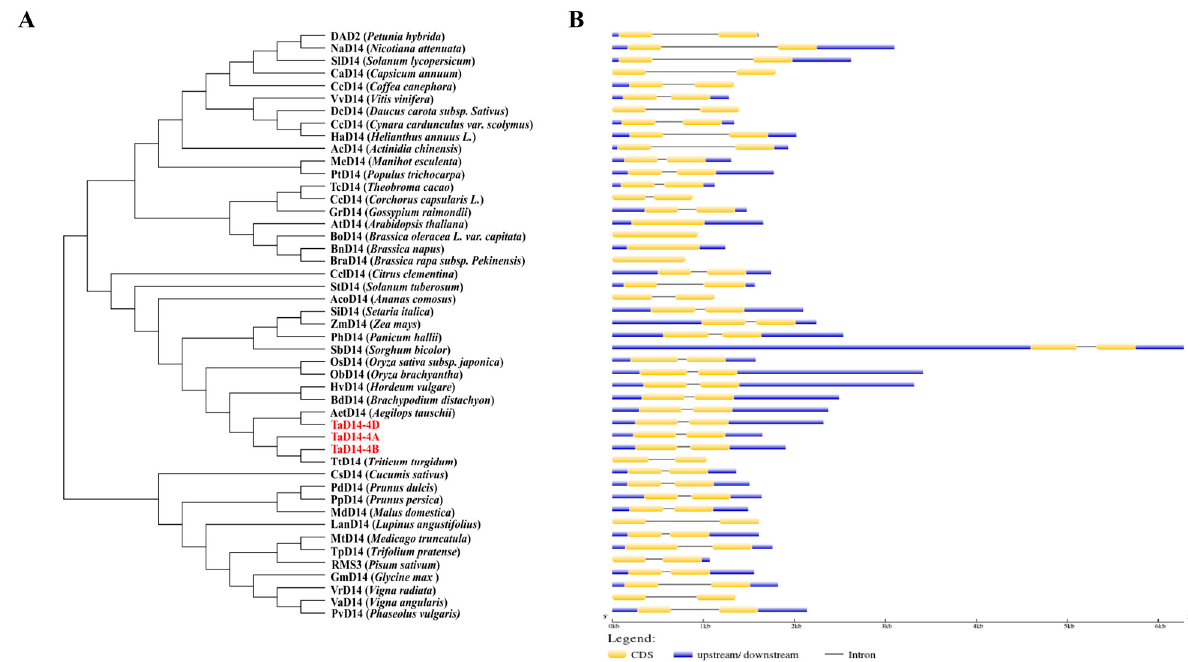
Figure 2. Phylogenetic relationships of D14 proteins in different species and the corresponding D14 gene structures. ( A ) Phylogenetic tree constructed from the D14 protein sequences of 47 different species using the neighbor-joining method with a bootstrap value of 1000 by MEGA7.0. Three homoeologous proteins of TaD14 are marked in red. ( B ) Gene structures of D14. The yellow boxes indicate coding sequences, the blue boxes represent the untranslated regions, and the black lines represent introns. The length of coding sequence (CDS) and introns can be estimated using the scale at the bottom.